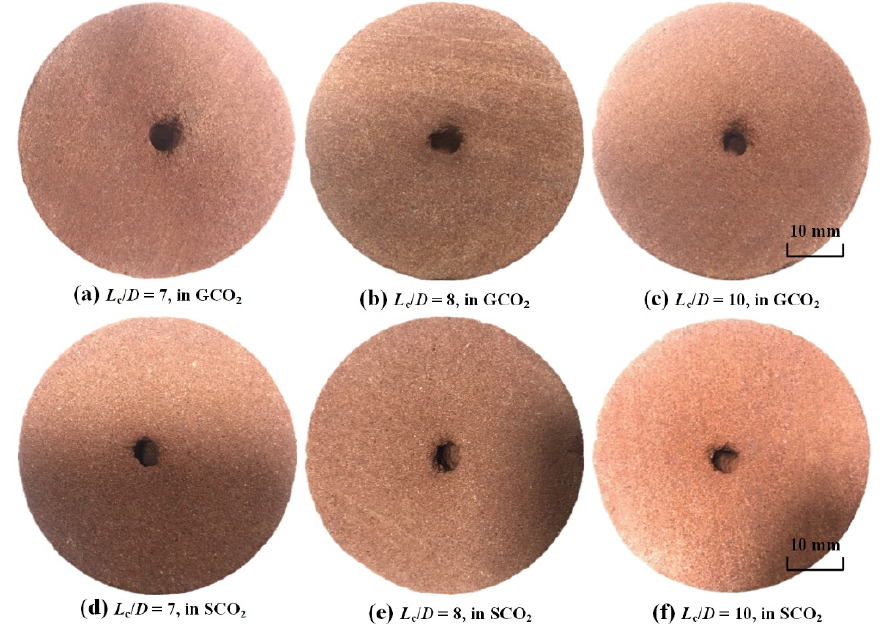
Figure 10. Variations of dominant oscillation frequency: ( a ) with the chamber length and ( b ) with the pressure difference. Experimental conditions: Δ P = 4–10 MPa, 5 ≤ L c / D ≤ 11, and P a = 6 or 8.5 MPa.